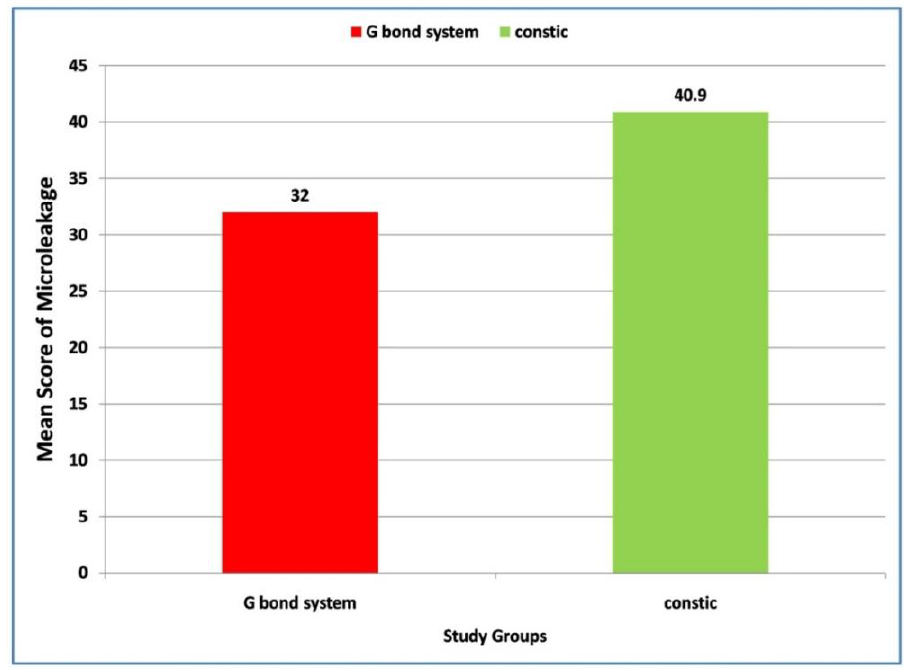
Figure 4. Comparison of mean values of microleakage in class V cavities with G-Bond system and Constic using G-aenial Universal Flo.